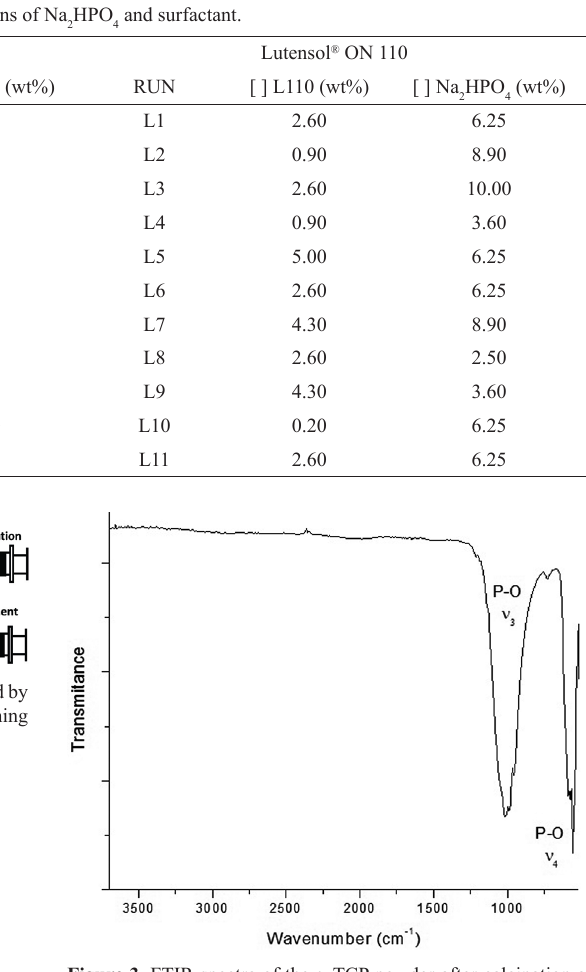
Figure 3. FTIR spectra of the α-TCP powder after calcination at